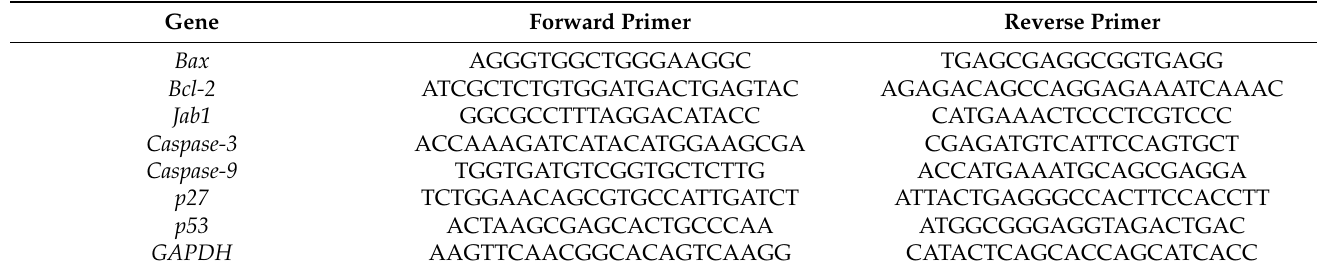
Table 1. Primers used in the